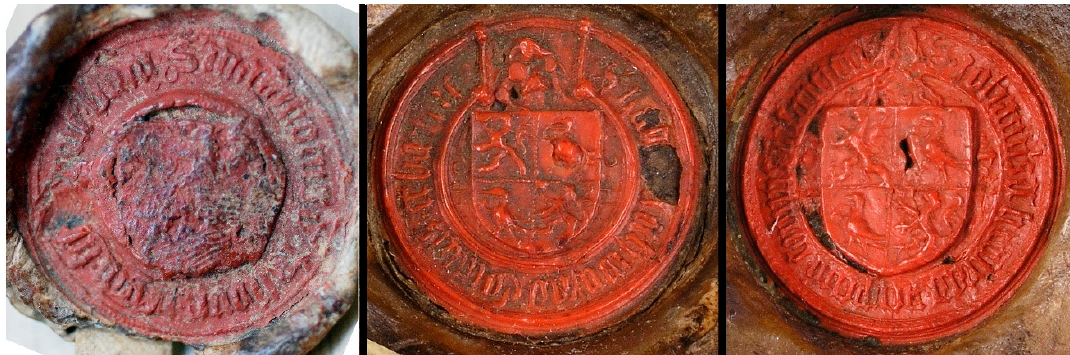
Figure 6. The seal of Matkó/Matthias Tallóci/Talovac, count of Cetina from 1442 ( left side ). Haus-, Hof- und Staatsarchiv, Allgemeine Urkundenreihe 1442. VIII. 16. The seals of John Hunyadi and his elder son, Ladislaus count of Beszterce/Bistritz/Bistri ț a from 1456 ( middle and right side ). Archiv Republike Slovenije SI AS Nr. 4567.